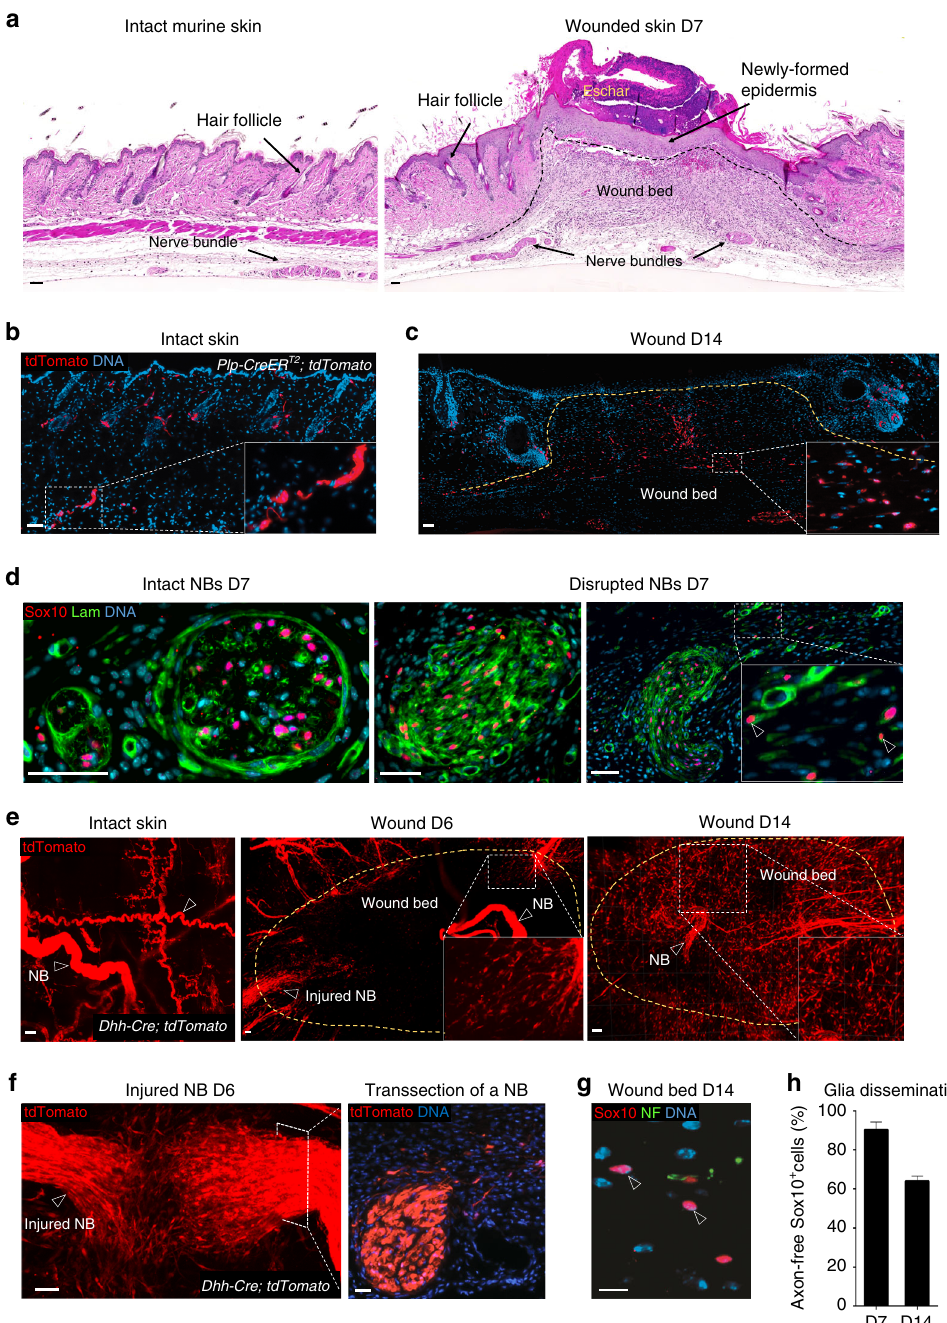
Fig. 1 Genetic tracing of the peripheral glial lineage in intact and injured skin. a H&E-stained sections of intact skin and full-thickness excisional wound of adult mice at day 7 (D7) post-surgery. b Glial lineage tracing of Plp-CreER T2 ; tdTomato intact skin of a TM-injected animal. Dermal compartment is mostly void of single-labelled cells. c Glial lineage tracing of Plp-CreER T2 ; tdTomato injured skin at D14 post-surgery in TM-injected animal. b , c Boxed regions in the dermis are shown at higher magni fi cation in the insets, highlighting the presence of multiple individual traced cells (red) populating the wound bed upon injury. d Immuno fl uorescence staining of skin NB for the transcription factor Sox10 and the extracellular matrix protein Laminin (Lam) in intact and D7 injured skin show disruption of perineurium and dissemination of Sox10 + cells upon injury. Arrowheads denote the presence of Sox10 + /Lam + cells outside the NB. e 3D imaging of the glial lineage of Dhh-Cre; tdTomato cleared intact mouse skin and cleared wounded skin at D6 and D14 show individual traced cells detached from NB upon injury. Arrowheads denote tdTomato-traced NBs. f An apparently damaged sprouting nerve was subsequently sectioned and immunolabelled for the lineage tracer tdTomato. g D7 and D14 wounded skin samples were subjected to immunolabelling to quantify the amount of glial cells (Sox10 + ) detached from NF-positive axons. Arrowheads denote glial cells with no adjacent NF staining and considered axon free. h The quanti fi cation of the extent of glial dissociation from axons shows that the vast majority of Sox10 + cells are not associated with axons at D7 and D14 (number of animals ( N ) = 4, number of wounds ( n ) = 8 (D7); N = 4 animals, n = 7 wounds (D14)). b , c , d , f , g sections were counter stained with Hoechst 33258 (blue). Scale bars, 50 µ m ( a – f ), 10 µ m ( g